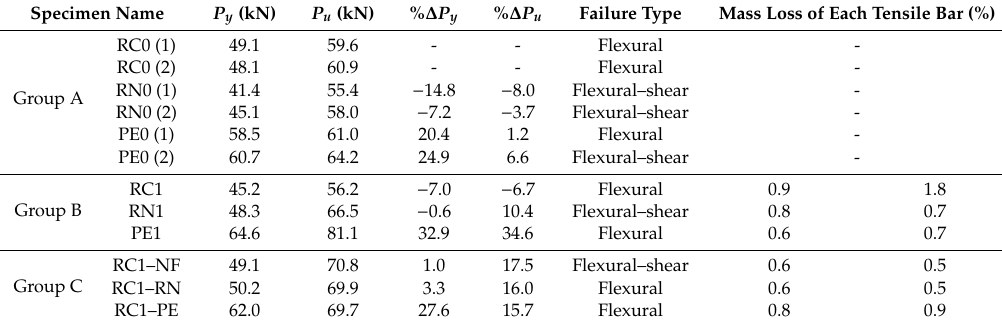
Table 6. Four-point flexural test results.